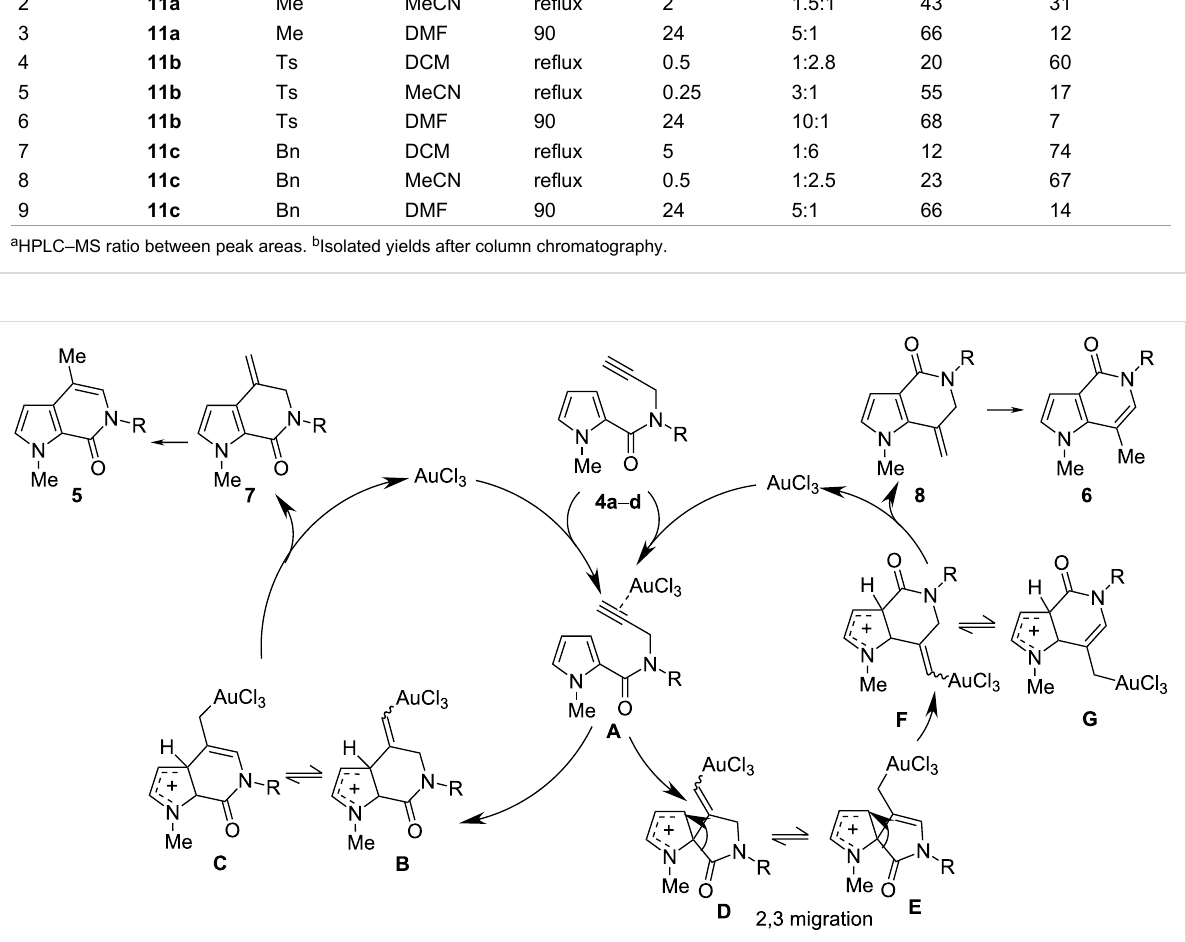
Table 4: Cyclization reactions on differently N -substituted N -(3-phenyl-prop-2-ynyl) pyrrole-2-carboxamides.